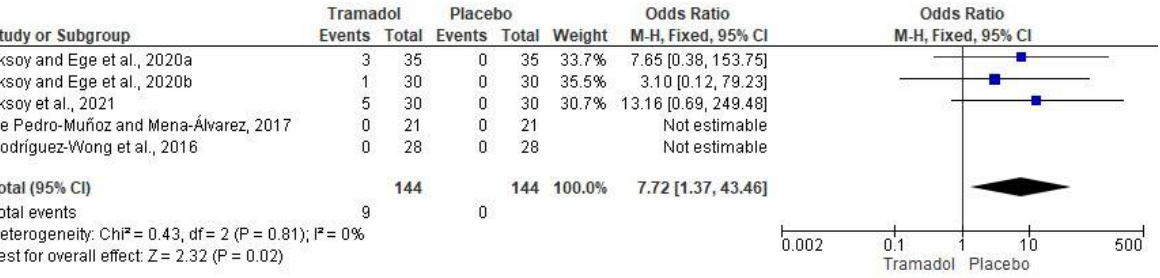
Figure 4. Pooled analysis on adverse effects of local tramadol and placebo/local anesthetics [13,15–17].